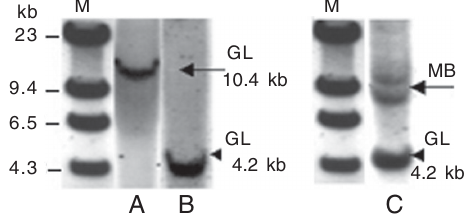
Figure 4. Southern blot of Eco RI fully digested DNA hybridized with Jbeta 1 or Jbeta 2 specific probe. A , Hybridization pattern in Jbeta 1 germ cells; B , hybrid- ization pattern in Jbeta 2 germ cells; C , hybridization pattern observed in a sample from a patient with leukemia using a probe for the Jbeta 2 segment. M = marker of DNA size; kb = kilobase pairs; MB = mono- clonal band; GL =